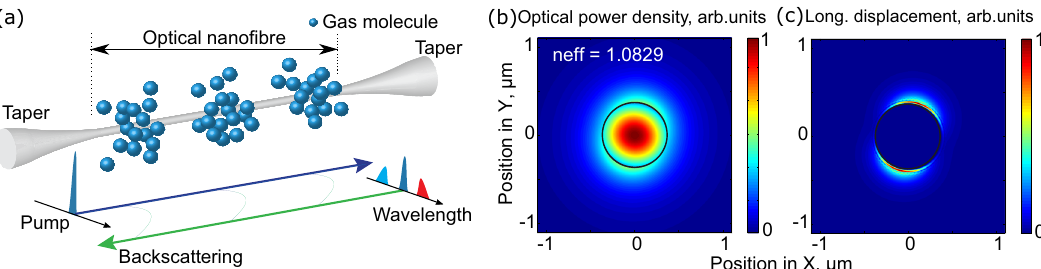
Fig. 1 Brillouin scattering in a nano fi bre gas cell. a Conceptual view of the Brillouin scattering in a nano fi bre gas cell. Pump (in green) goes from left to right and the backscattered light includes Rayleigh scattering from the same frequency and frequency down-shifted Stokes (in red) and frequency up- shifted anti-Stokes (in blue) Brillouin scattering. b Computed normalised spatial optical power distribution of the fundamental optical mode at a wavelength of 1550 nm for a 740 nm diameter nano fi bre surrounded with 40 bar CO 2 gas. The effective mode refractive index is 1.0829. c Computed normalised longitudinal displacement of the elastic wave at 350 MHz as a result of backward Brillouin scattering in the surrounding gas. The black circles in ( b ) and ( c ) show the silica nano fi bre boundary. See Methods for the simulation